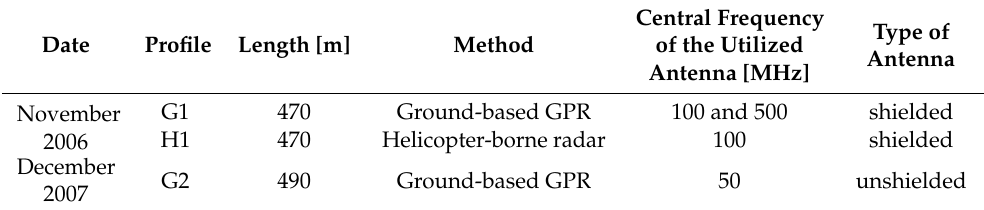
Table 4. Technical information on the measuring equipment used during the field work performed at Fourcade Glacier in